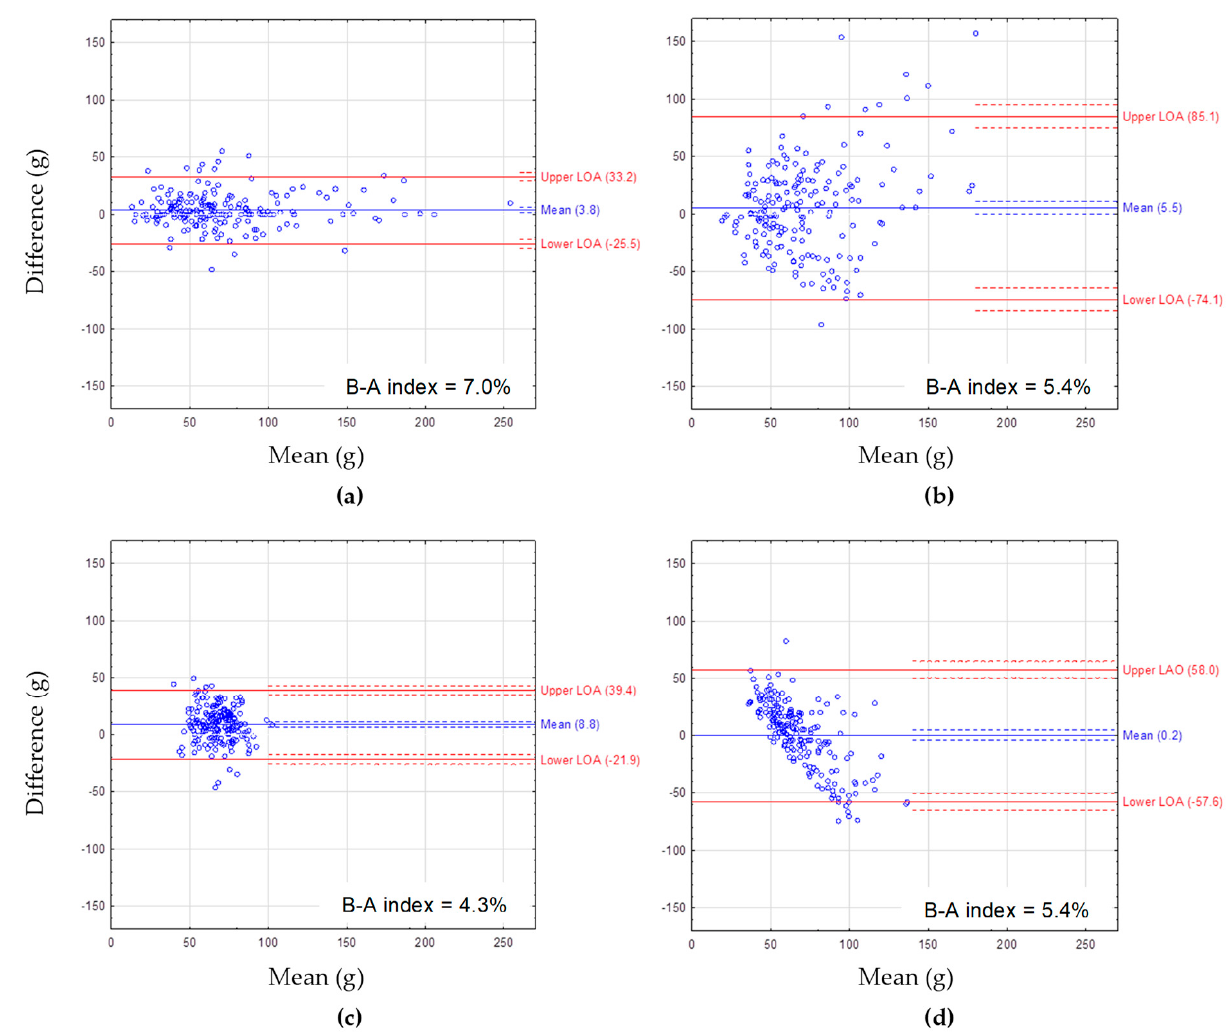
Figure 2. The Bland–Altman plots for fat intake assessed with: ( a ) FFQcrude and FFQretest, ( b ) FFQcrude and FRcrude, ( c ) FFQstand and FRstand, ( d ) FFQreg and FRcrude. FFQcrude—crude data from the first administration of the FFQ (test), FFQretest—crude data from the second administration of the FFQ, FRcrude—crude data from the 2-day estimated food record (FR), FRstand—the FR data after standardization of energy intake, FFQstand—the FFQ data after standardization of energy intake, FFQreg—the FFQ data adjusted by regression. Mean—mean difference in fat intake between the methods (blue solid line) with 95% CI (dashed lines). LOA—95% limits of agreement between the methods (red solid lines) with 95% CI (dashed lines). B-A index—the Bland–Altman index calculated as percentage of respondents beyond LOA.